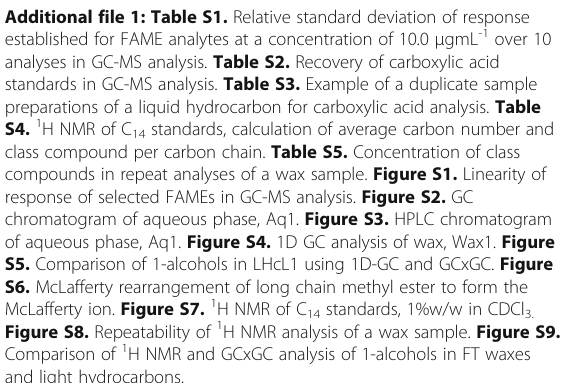
Figure S8. Repeatability of 1 H NMR analysis of a wax sample. Figure S9. Comparison of 1 H NMR and GCxGC analysis of 1-alcohols in FT waxes and light